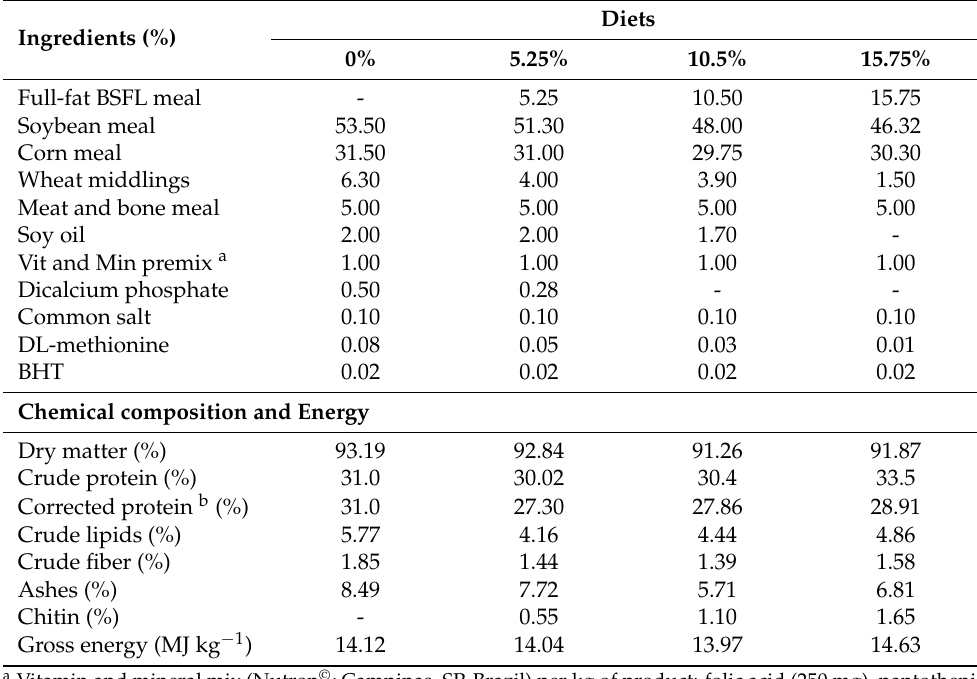
Table 2. Formulation and composition of the experimental diets (on dry matter